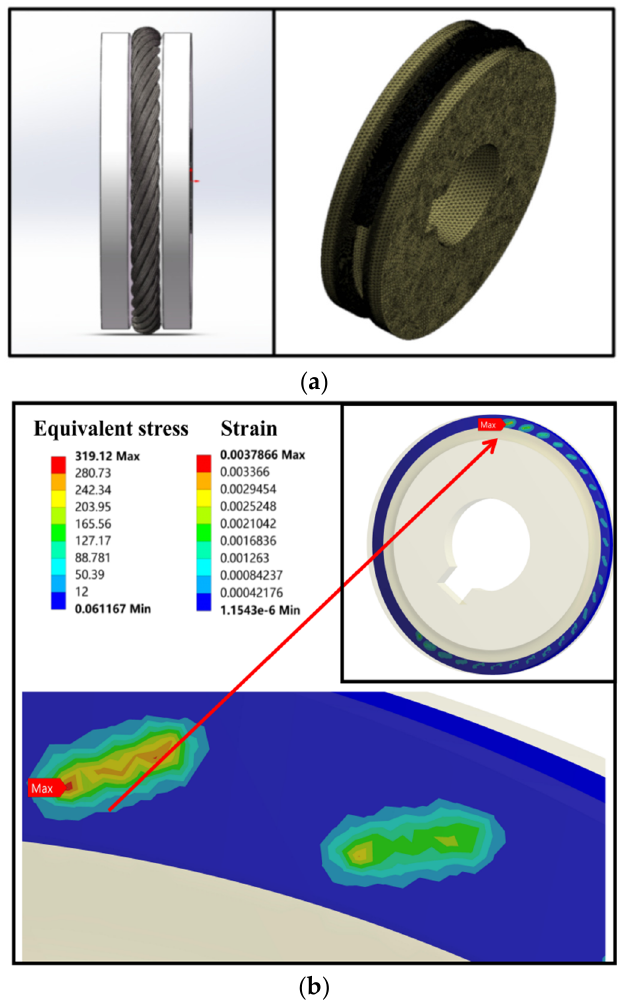
Figure 12. Contact stress and strain analysis of traction wheel. ( a ) Solidworks model of rope–wheel system. ( b ) Contact stress and strain analysis of traction wheel and wire rope.